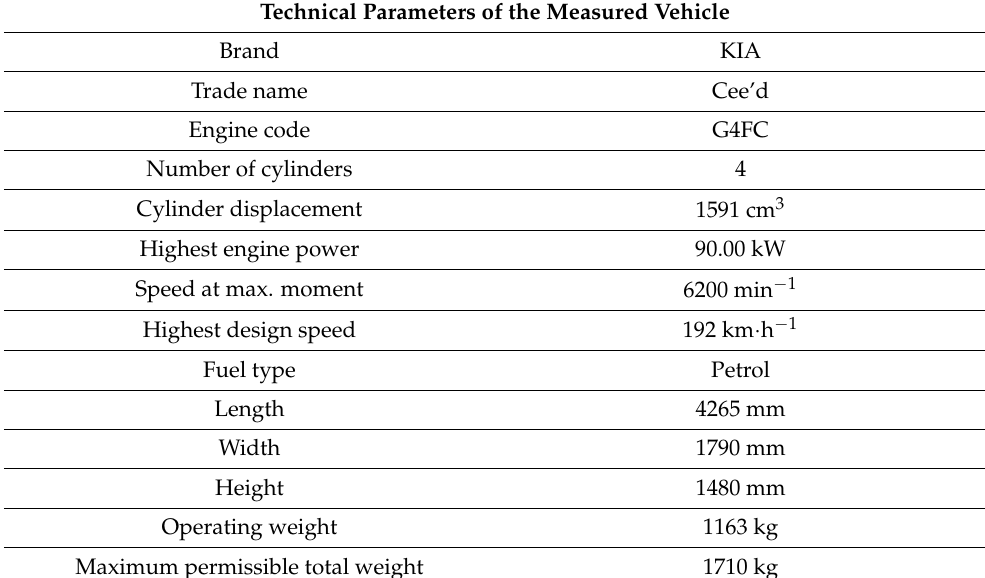
Table 1. Technical parameters of Kia Ceed (data processed by the author). Technical Parameters of the Measured